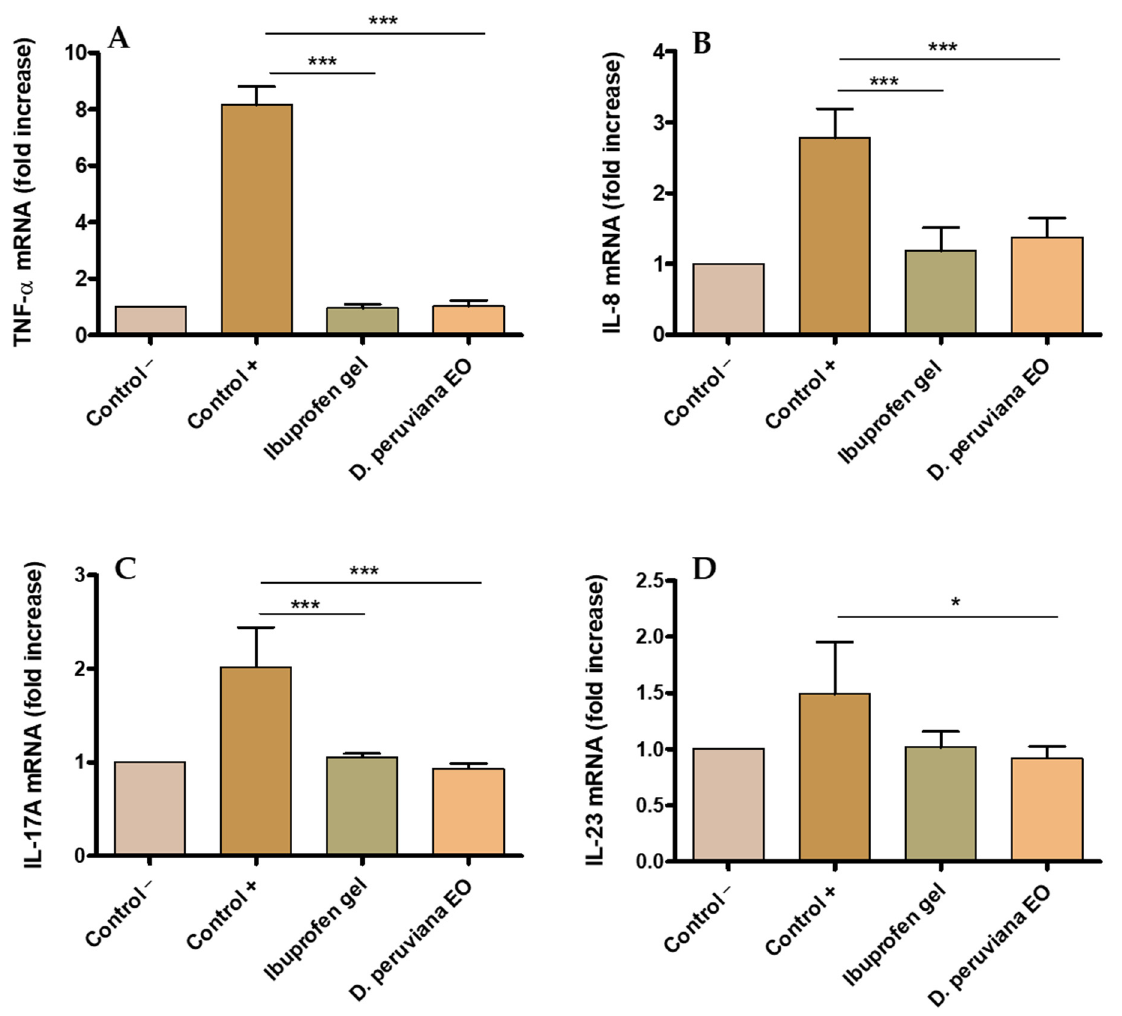
Figure 4. Expression of pro-inflammatory interleukins obtained by quantitative reverse transcription polymerase chain reaction (RT-qPCR): ( A ) tumor necrosis factor-alpha (TNF- α ); ( B ) interleukin-8 (IL-8); ( C ) interleukin-17A (IL-17A); and ( D ) interleukin-23 (IL-23). Negative control (control − ), positive (control +), treatment with reference drug (Ibuprofen gel), treatment with D. peruviana EO. Results are shown as mean ± SD ( n = 3). Statistically significant difference: * = p < 0.05, *** = p < 0.001.